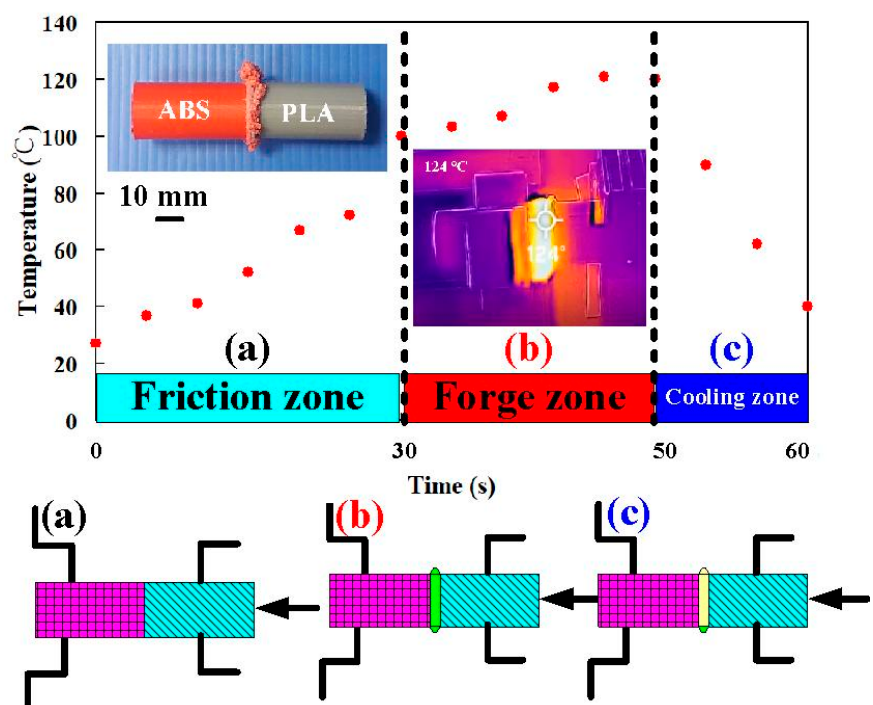
Figure 8. Changes of weld bead temperature as a function of time for three important stages of FRW